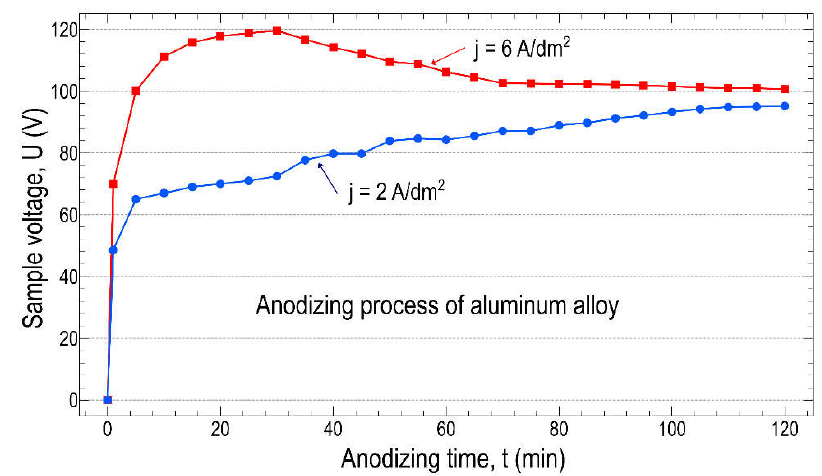
Figure 6. Anodic potential of samples as a function of time at low and high current densities .